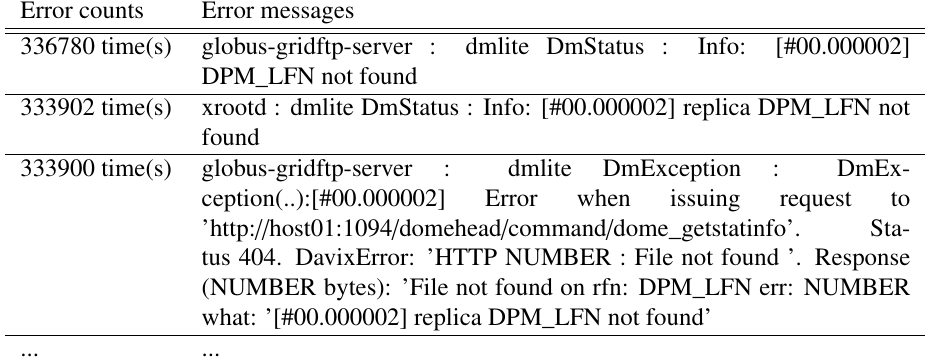
Table 1: An example of output by Logwatch for the DPM